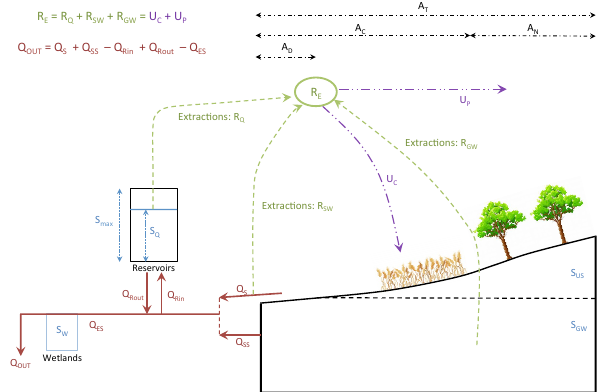
Figure 4. A simple catchment water balance model that includes the minimum necessary components for application of the concep- tual framework. Groundwater ( S GW ), vadose zone ( S US ), wetland ( S W ) and reservoir ( S Q ) water stores are included. Cumulative man- made storage capacity ( S max ) must also be included. Net flows ( Q OUT ) are modelled using surface flow ( Q S ), subsurface flows ( Q SS ), managed diverted ( Q Rin ) and released ( Q Rout ) flows, and environmental flows ( Q ES ). Managed extractions made from the system from each of groundwater ( R GW ), surface ( R SW ) and reser- voir ( R Q ) sources must be accounted for. Land use decisions must also be reflected, such that area of land cleared ( A C ), area of remain- ing land comprised of natural vegetation ( A N ) and area of degraded land ( A D ) must form a dynamic part of the